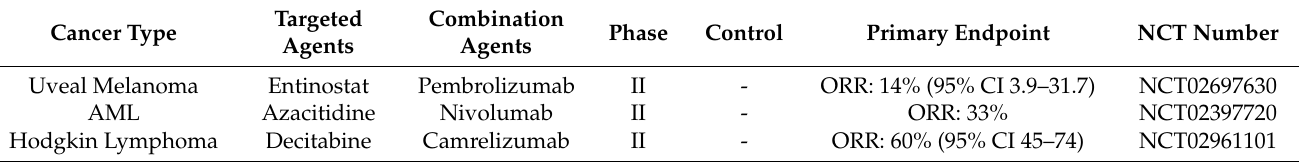
Table 3. Clinical trials of ICIs plus epigenetic